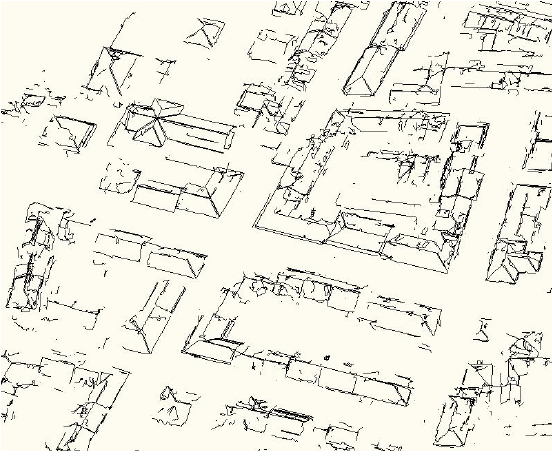
Figure 14. Achieved result in the aerial